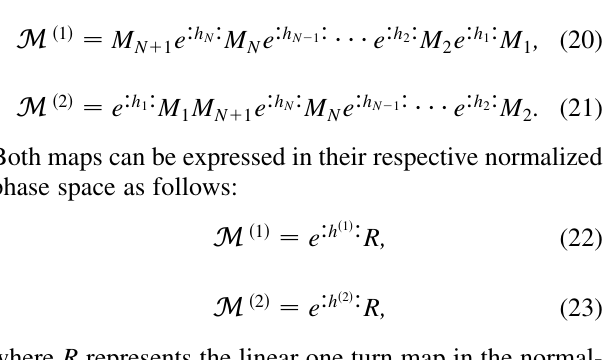
in sigmas for the SPS with x